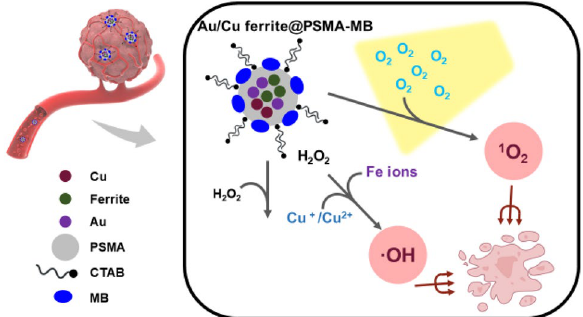
Figure 1. The mechanism of HeLa cell apoptosis is triggered by MB Au/Cu ferrite oxide-polymer core–shell